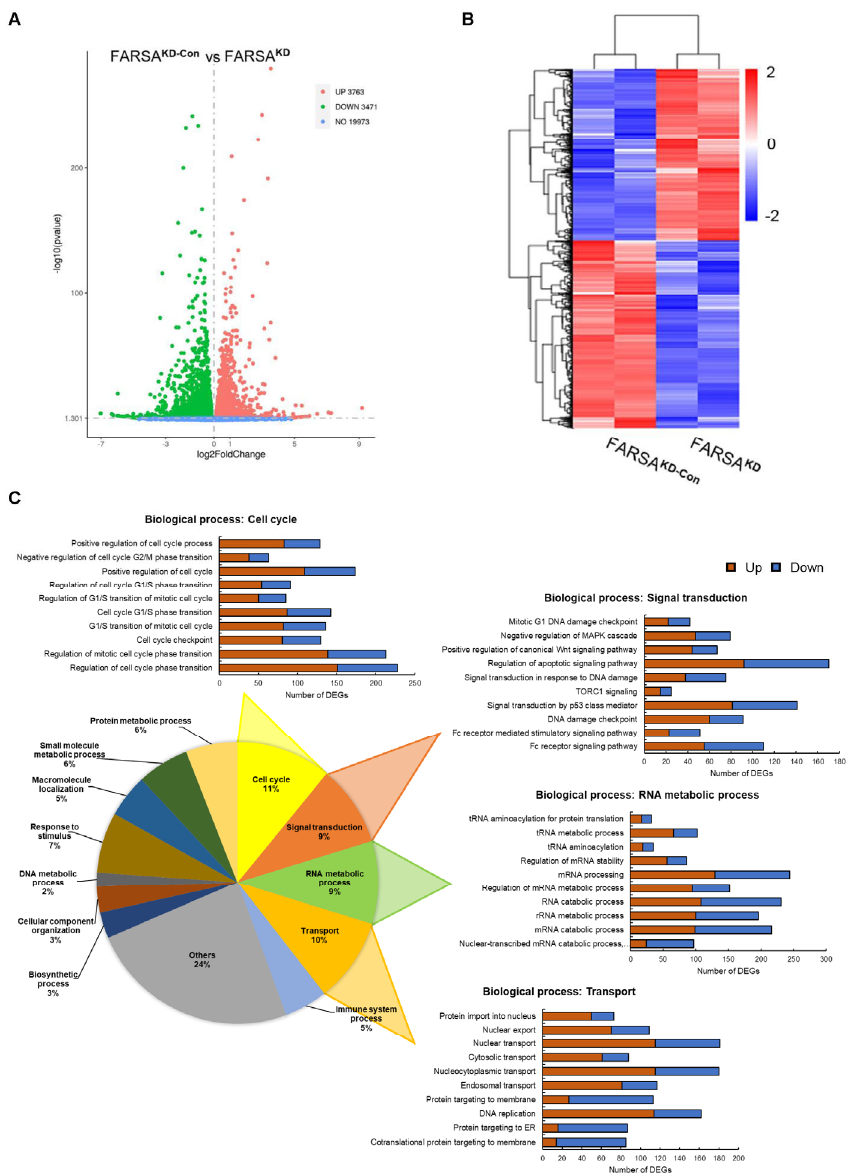
Figure 4. The differentially expressed genes (DEGs) and the Gene Ontology (GO) terms enriched in the biological process category affected by FARSA in Jeko cells. ( A ) Volcano plots of RNA sequencing (RNA-seq) data in FARSA KD Jeko cells relative to the control cells. Green dots represent the downregulated DEGs (n = 3471) and red dots represent the upregulated DEGs (n = 3763), whereas blue dots (n = 19973) represent genes not significantly altered. ( B ) Heatmap of RNA-seq data from independent samples (n = 2/group) of FARSA KD and FARSA KD-Con Jeko cells. The fold change in gene expression is indicated by the color intensity, with blue representing the downregulated DEGs and red representing the upregulated DEGs. ( C ) The pie chart displaying the sub-categories of the GO terms enriched in the “biological process” category based on the AmiGO 2 software. The detailed GO terms in four representative sub-categories are shown around the pie chart, with red representing the upregulated DEGs and blue representing the downregulated DEGs.